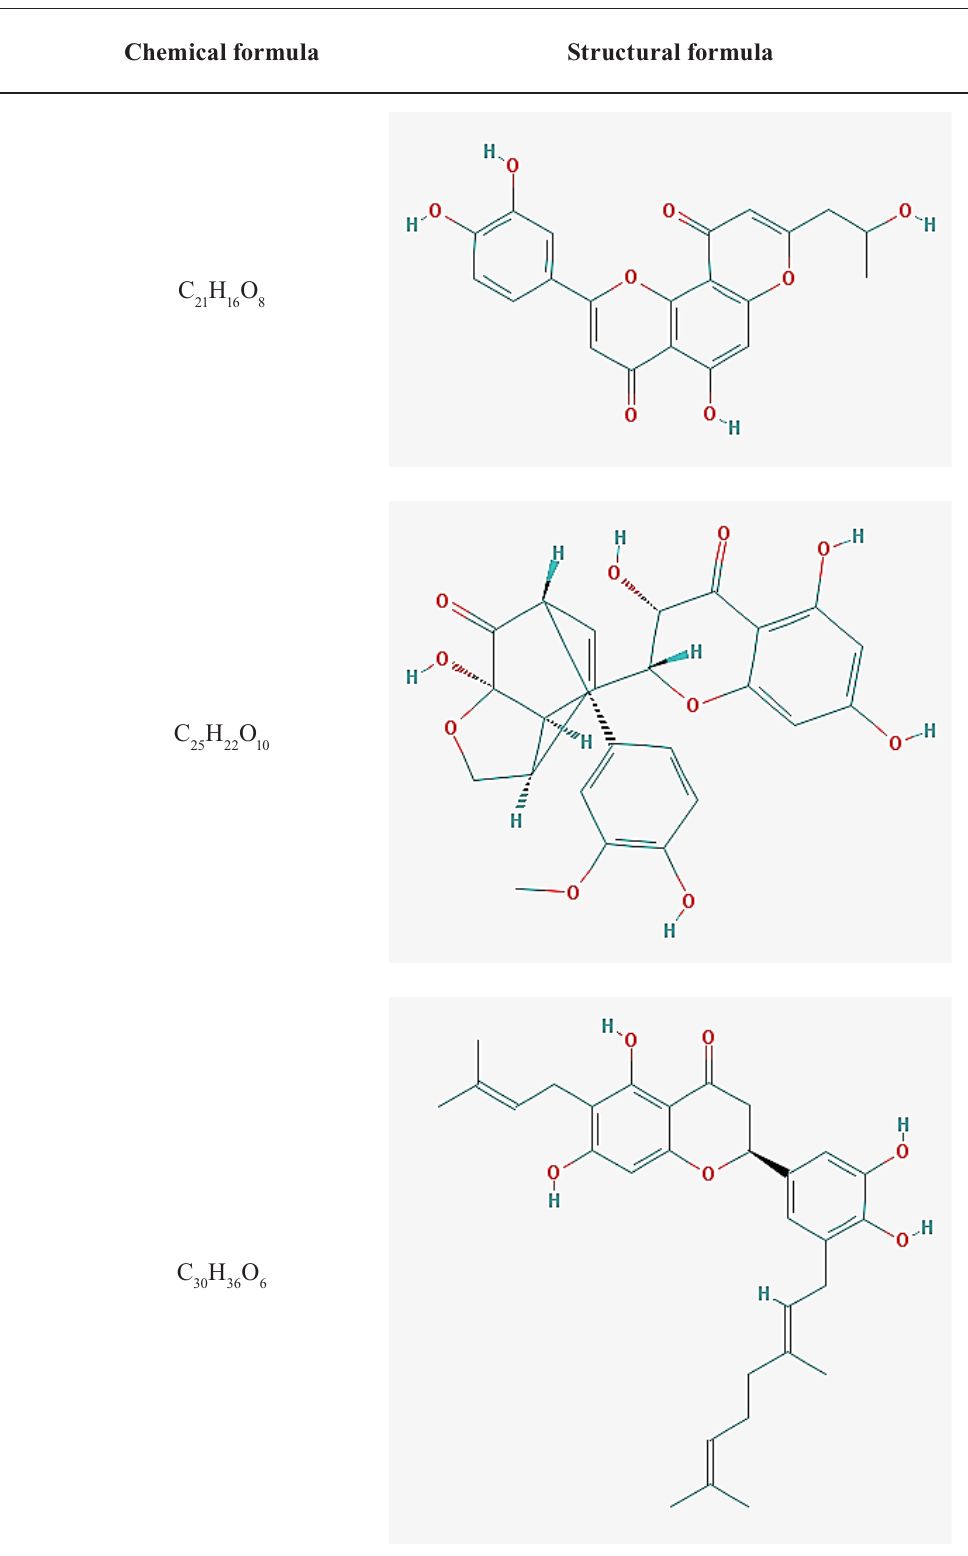
TABLE I - P hytochemicals from Tanacetum parthenium and Silybum